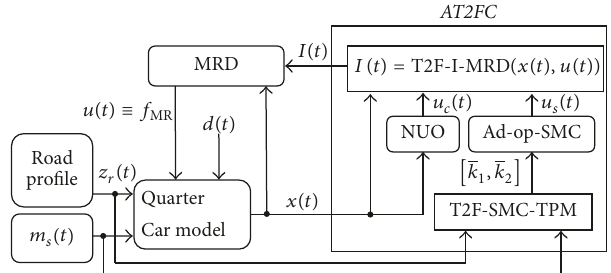
Figure 5: The structure and operating principle of the proposed controller AT2FC.